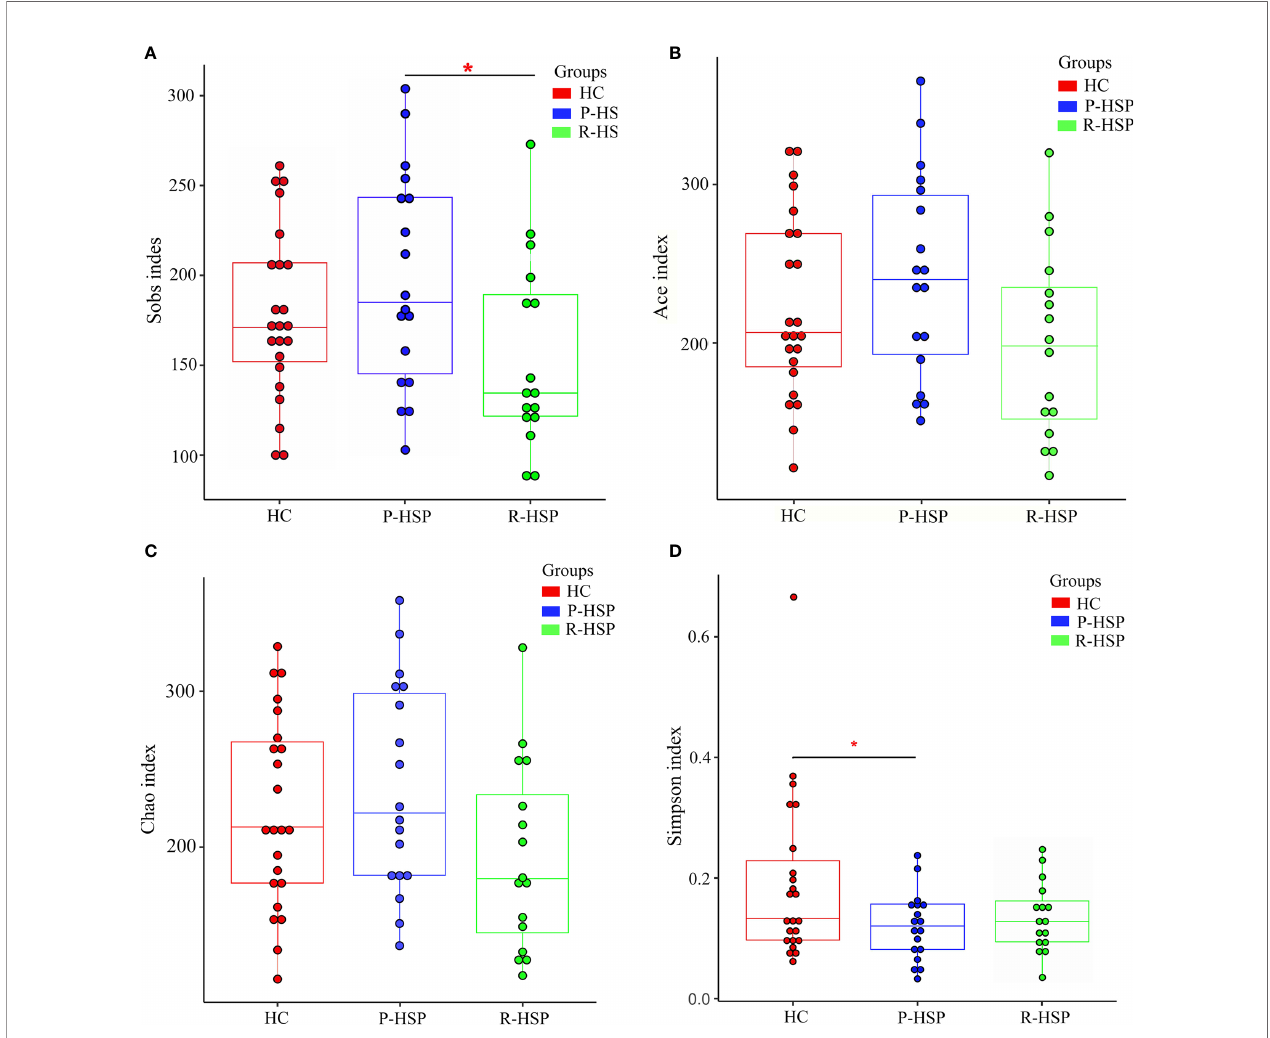
FIGURE 1 | Comparison of a -diversity indexes between patients with primary HSP and recurrent HSP and healthy controls in terms of species richness and adversity. The Y-axes stand for the scores of the a -diversity index, and the X-axes show the phenotypic categories. The box depicts the interquartile range between the fi rst (25 th percentile) and third (75 th ) percentile, and the line inside the box denotes the median. (A) The Sobs index displays higher species richness in patients with primary HSP than in patients with recurrent HSP and healthy controls, but the difference was signi fi cant only when compared with the species richness in patients with recurrent HSP ( P < 0.05). (B) There was no signi fi cant difference in ACE indexes between the three groups (primary HSP vs . healthy controls P > 0.05; recurrent HSP vs . healthy controls P > 0.05; primary HSP vs . recurrent HSP P > 0.05). (C) Chao index was the lowest in the recurrent HSP group, but the difference was not statistically signi fi cant (primary HSP vs . healthy controls P > 0.05; recurrent HSP vs . healthy controls P > 0.05; primary HSP vs . recurrent HSP P > 0.05). (D) The Simpson diversity index in the primary HSP group was lower than that in the healthy control group ( P < 0.05) and recurrent HSP group ( P > 0.05), but the difference was not statistically signi fi cant. *P <